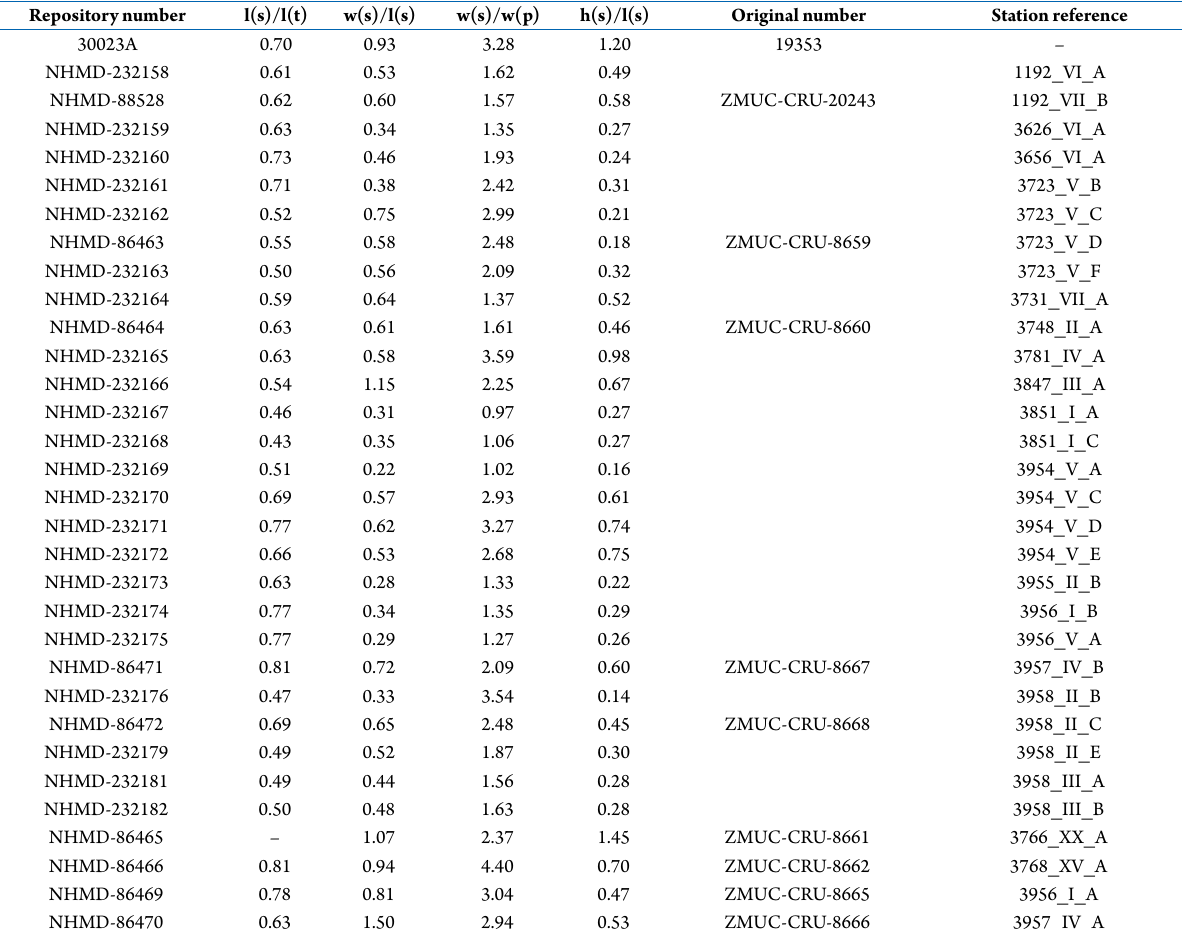
Table 1. Calculated ratios of the relative measurements of the specimens (see Fig. 1 for details); abbreviations: h(s) = height of shield; l(s) = length of shield ; l(t) = total length; w(p) = maximum width pleon; w(s) = maximum width shield. In addition to the repository numbers of the specimens in museum collections, also the original numbers (where present) and the reference to the station the specimens had been collected are